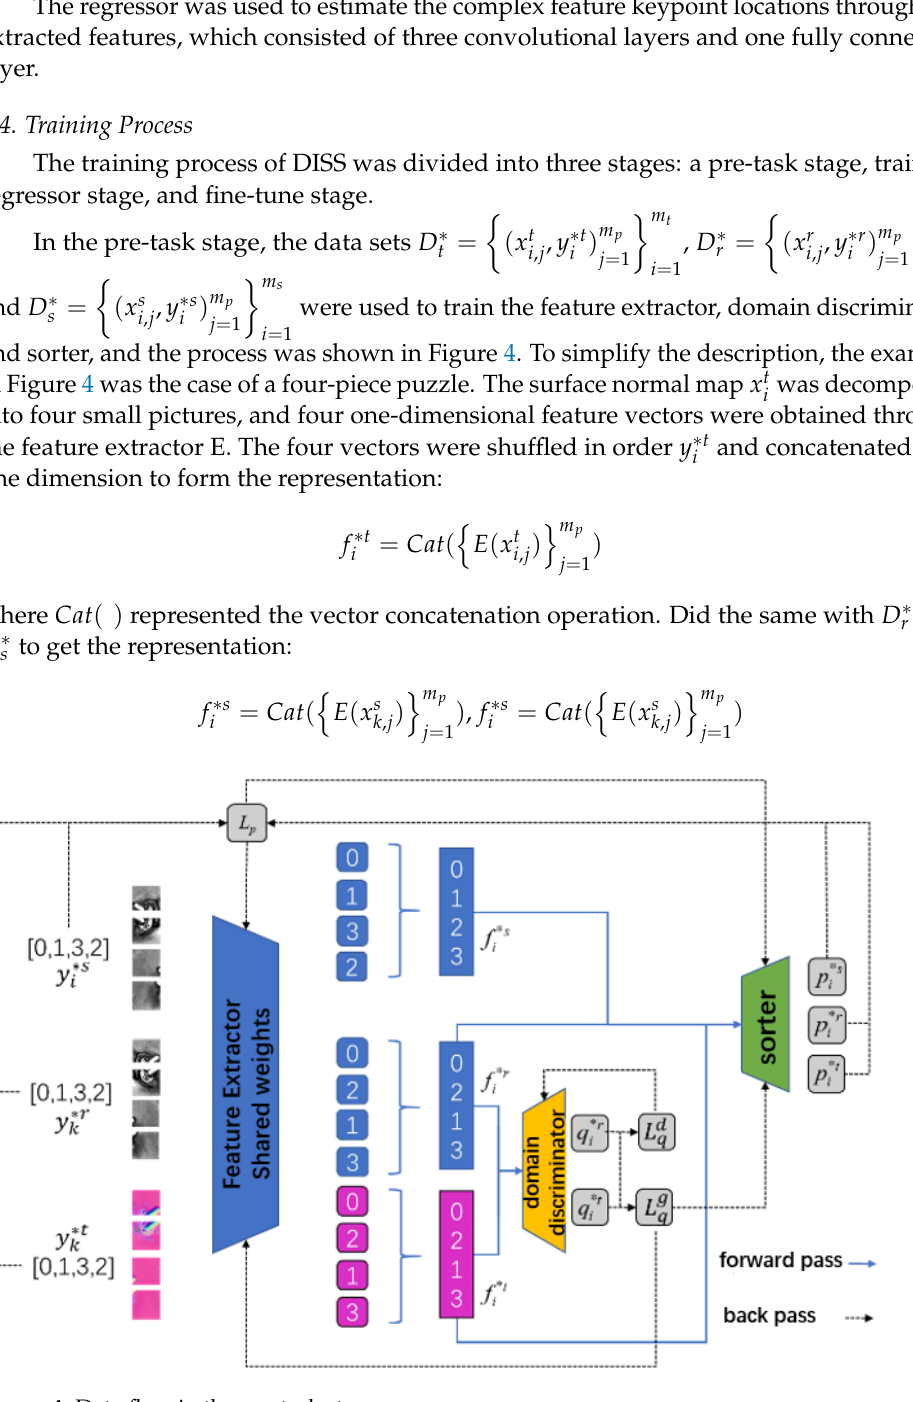
Figure 4. Data flow in the pre-task stage. Algorithm 1 Pre-task training algorithm